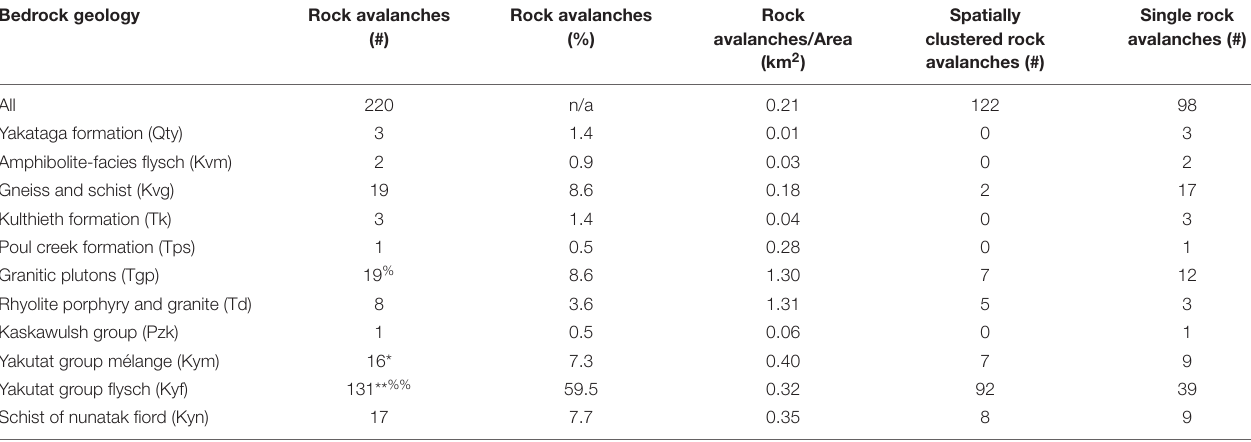
Rock avalanches Rock Spatially Single rock (#) (%) avalanches/Area clustered rock avalanches (#) (km 2 ) avalanches (#)